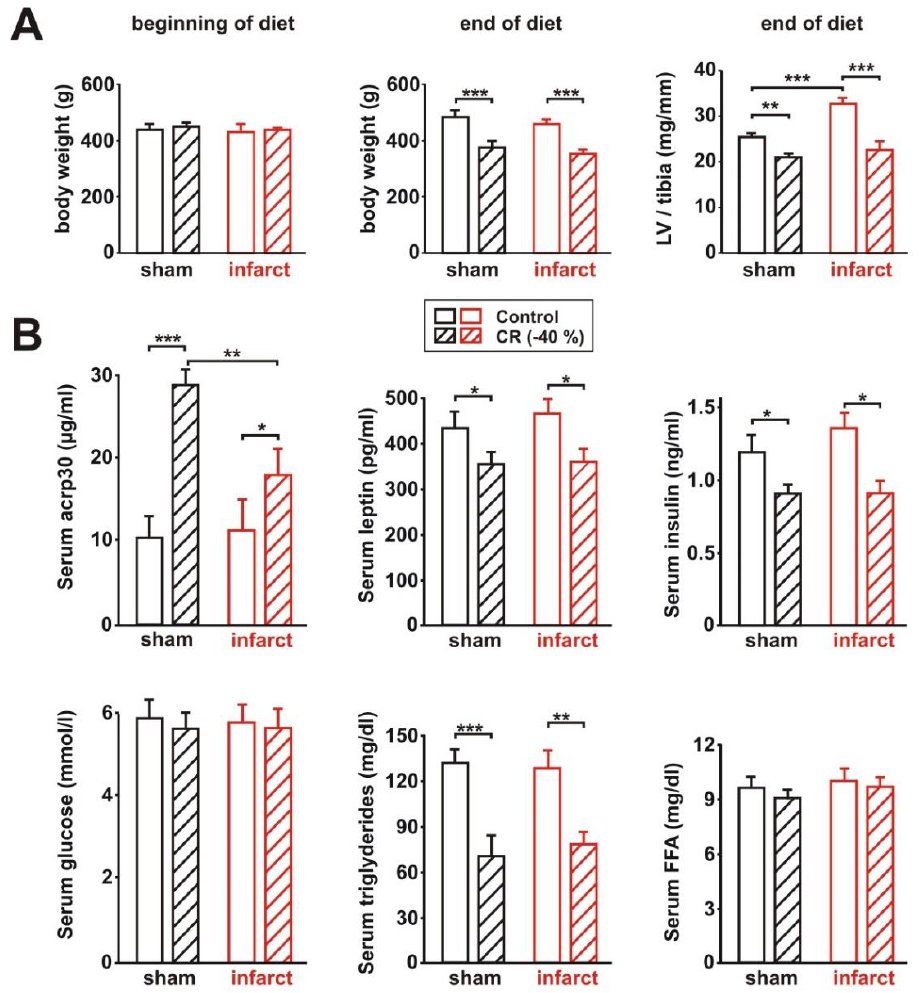
Figure 1. Effect of 8 weeks CR on body weight and plasma parameters. ( A ): Body weight at the beginning of the diet (left panel), end of the diet (middle panel), and LV weight normalized to tibia length at the end of the diet (right panel) in sham or infarct rats, following 8 weeks of control or CR diets. ( B ): Serum levels of acrp30, leptin, insulin, glucose, triglycerides, and free fatty acids (FFA) in these rats, obtained after overnight fasting. All data are mean ± SEM. n = 5–6 animals per group, *: p < 0.05; **: p < 0.01; ***: p < 0.001.